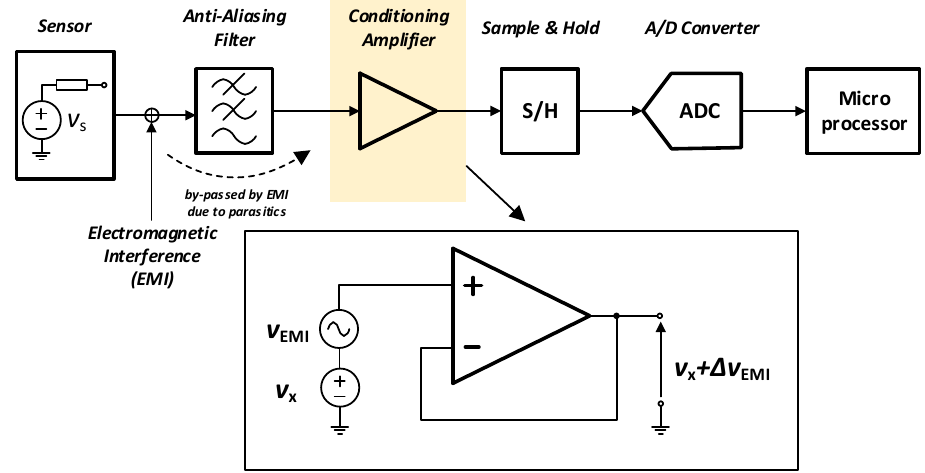
Figure 1. Acquisition Front-End